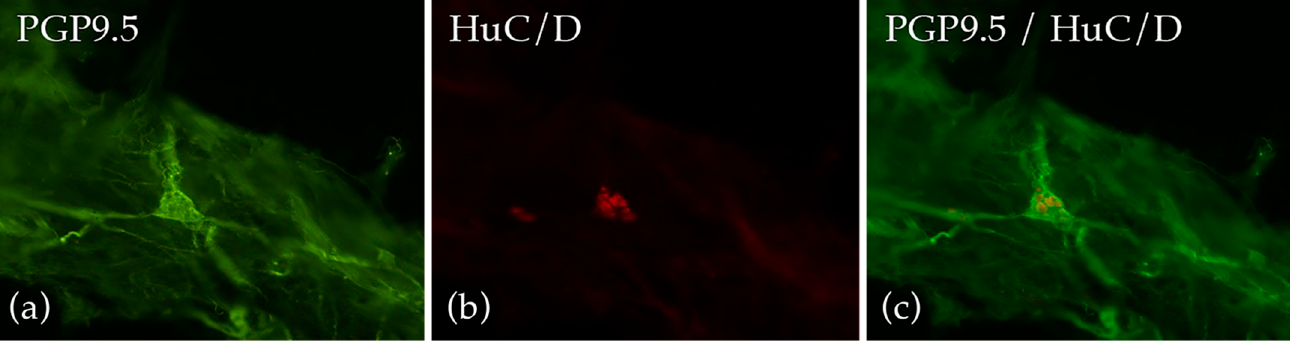
Figure 6. Morphological analysis on human submucosal plexi from colonic standard submucosal biopsies. The used primary antibodies encounter two general pan-neuronal markers, i.e.: ( a ) PGP9.5 recognizing perikarya and nerve fibers and ( b ) HuC/D detecting only neuronal cell bodies for quantitative analysis. ( c ) The two neuronal markers, PGP9.5 and HuC/D, used simultaneously. Giancola, Brock and de Giorgio, unpublished data.